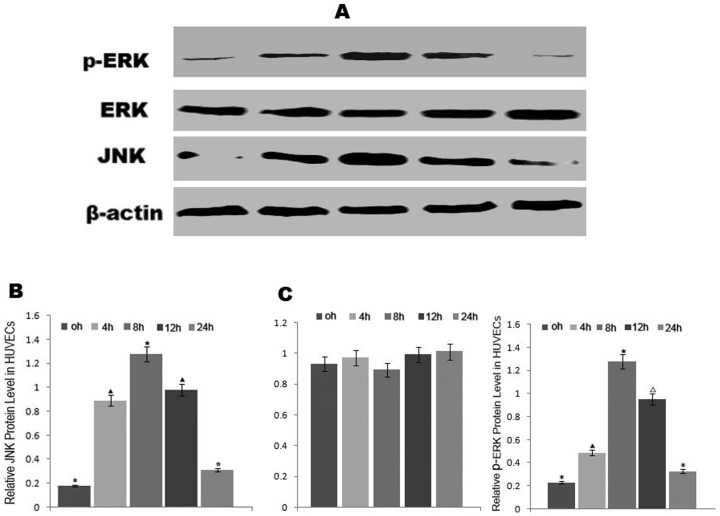
AngII treatment increased JNK and P-ERK expression in HUVECs by western blotting.(A) JNK and P-ERK expression levels. (B) Semi-quantitative analysis of the JNK levels. (C) Semi-quantitative analysis of the levels. Different symbols indicate statistical significance (p<0.05). The same symbols or no symbols indicate no statistical significance (p>0.05).